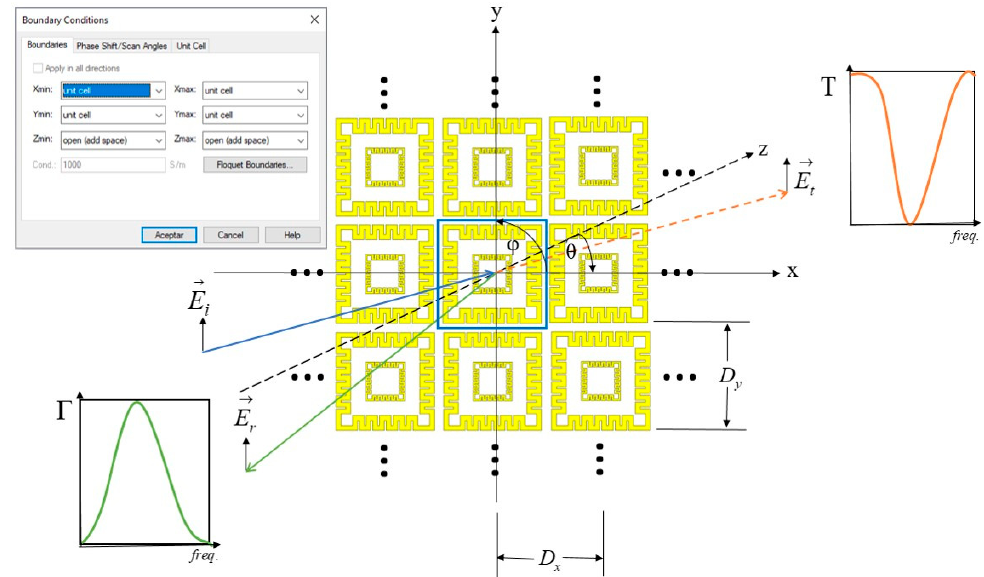
Figure 3. FSS structure excited by an incident plane wave ( Ei ), which is reflected ( Er ) and transmi tt ed ( Et ).